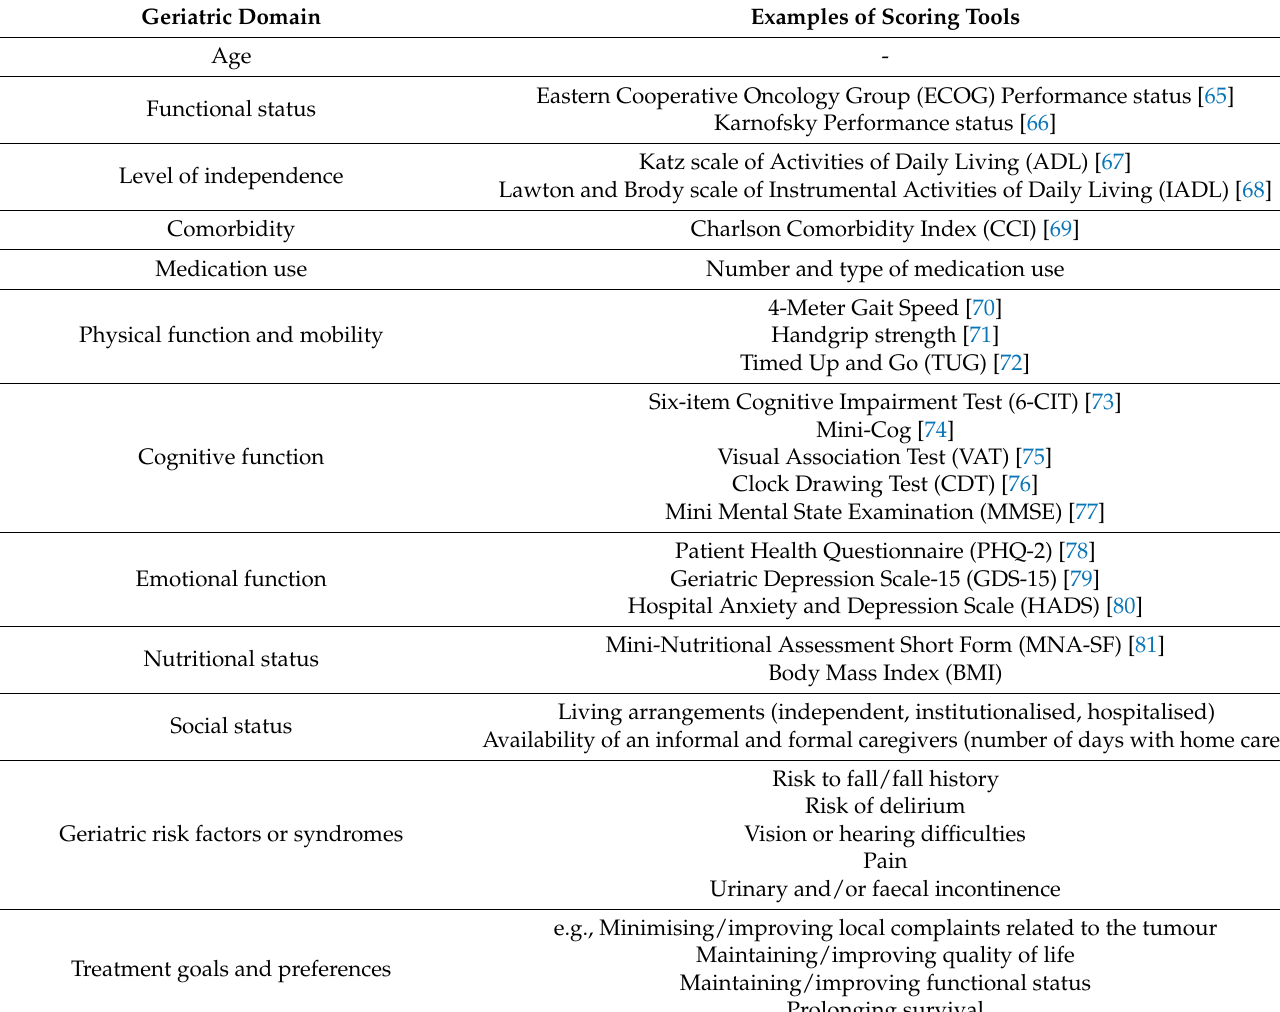
Table 1. Elements of the comprehensive geriatric assessment within the non-operative management of elderly and frail rectal cancer